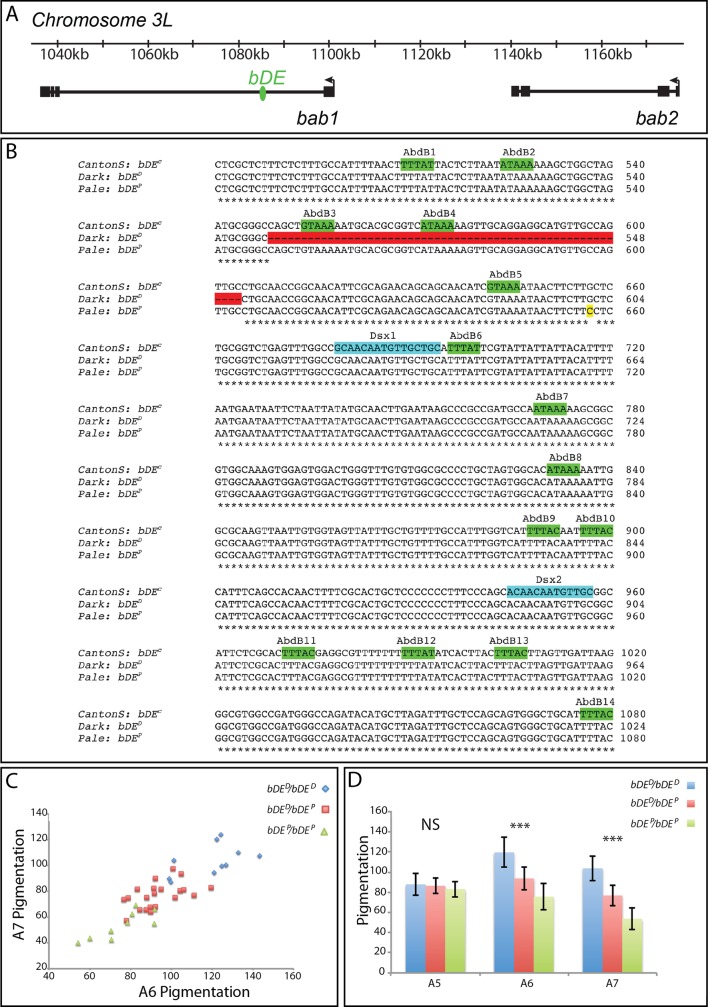
Pigmentation difference between the Dark and Pale lines is mainly linked to the bab locus.A: Schematic representation of the bric à brac locus of D. melanogaster containing the two paralogues bab1 and bab2. Rectangles indicate exons and lines introns. The transcription start sites of bab1 and bab2 are marked by arrows. The bab dimorphic element (bDE, in green, [21]) is located in the first intron of bab1. B: Sequence of the bab dimorphic element (bDE) from the Canton S [21] (bDEC allele), Dark (bDED allele) and Pale (bDEP allele) lines. Binding sites for Abdominal-B (Abd-B) and Doublesex (Dsx) previously identified [21] are indicated on the Canton S sequence in green and blue, respectively. The haplotypes of the Dark and Pale lines differ from that of Canton S by a 56 bp deletion (red) and a single bp substitution (yellow), respectively. C: Scatter plot for pigmentation in A6 and A7 of 40 individuals among the F2 progeny of an initial Dark x Pale cross performed at 25°C, that were genotyped at the bab locus. The three genotypes clearly segregate. D: Quantification of pigmentation in A5, A6 and A7 of the F2 individuals according to their genotype at the bab locus. In A6 and A7, pigmentation differs between the three genotypes, which is not the case in A5. Statistical test: one-way ANOVA. ***: p<0.001. NS: non significant.